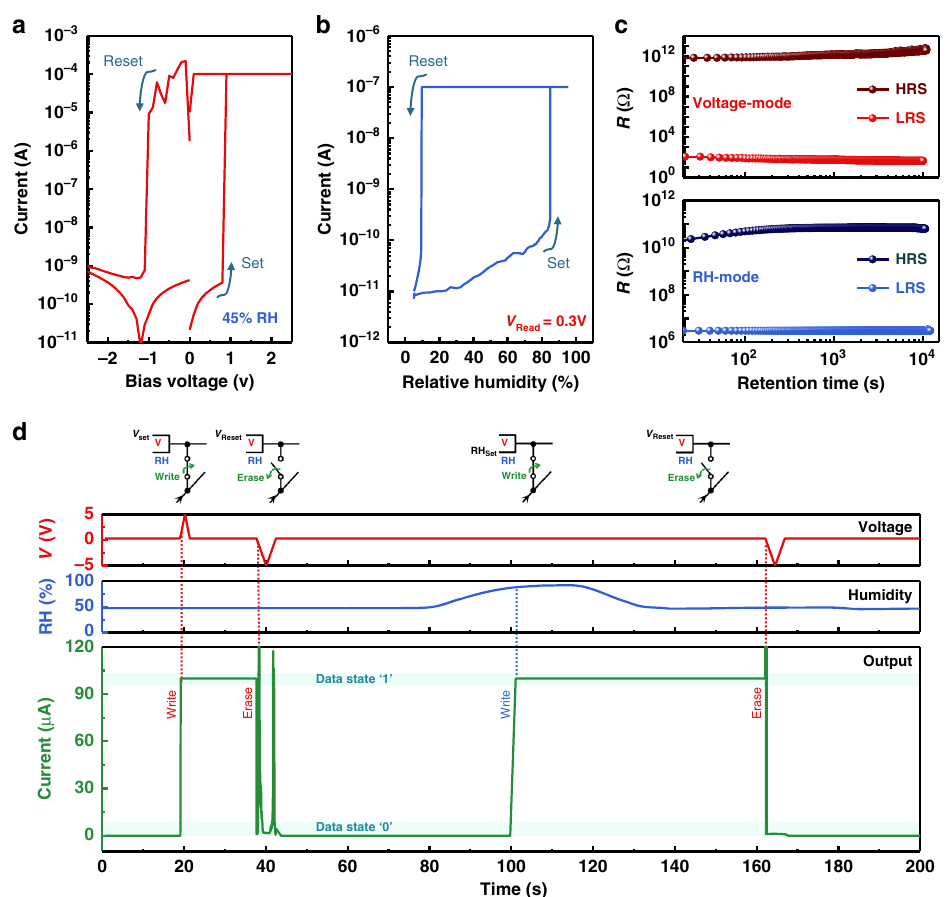
Fig. 3 Proton/electron controlled bimodal memristor based on the Y7C peptide. ( a ) Current – voltage characteristics of the device at a relative humidity of 45%. The voltage sweep direction (0 → 2 → − 2 → 0 V) is displayed with navy arrows. ( b ) Current humidity characteristics of the device with a constant read voltage of 0.3 V. The RH sweep direction (5 → 95 → 5%) is displayed with navy arrows. ( c ) Data retention characteristics of the device in voltage mode (top) and RH mode (bottom). ( d ) The current variation of the Y7C peptide memristor controlled by voltage and/or RH input, clearly showing bimodal operation. Voltage pulse, RH pulse, and current output are represented by red, blue and green curves,